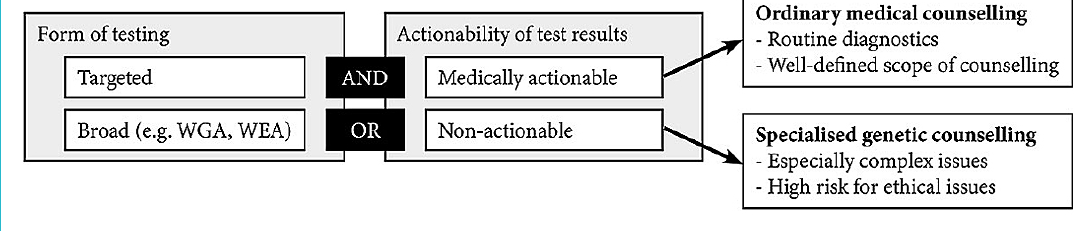
Figure 1: Illustration of factors influencing who should provide genetic counselling for presymptomatic genetic testing. The "AND" operator in- dicates that both indicators need to be fulfilled for ordinary medical counselling, the "OR" operator means that one of them is sufficient to quali- fy for specialised genetic counselling. WGA = whole-genome analyses; WEA = whole-exome